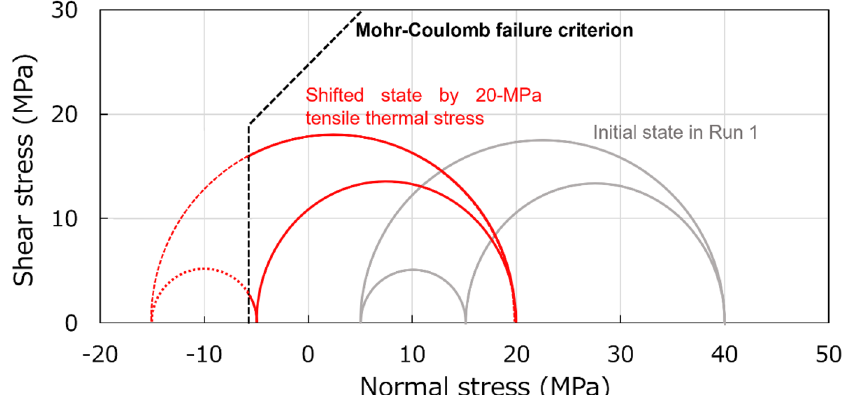
Fig. 12 Mohr’s circles at the initial state in Run 1 ( σ 1 / σ 2 / σ 3 : 40/15/5 MPa), and its horizontal shift by 20 MPa tensile thermal